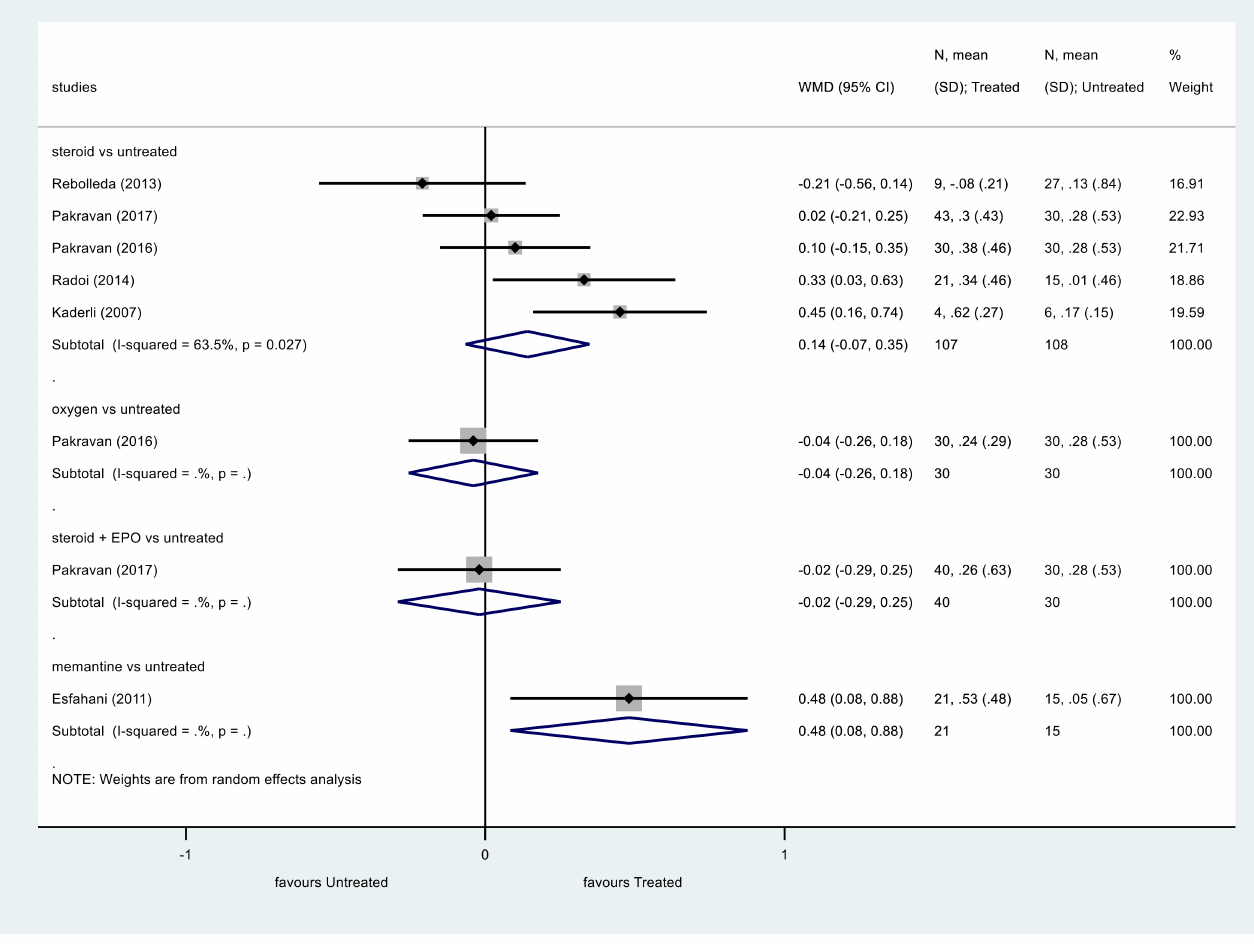
Figure 2. Comparison of interventions to no treatment regarding visual acuity (as a continuous